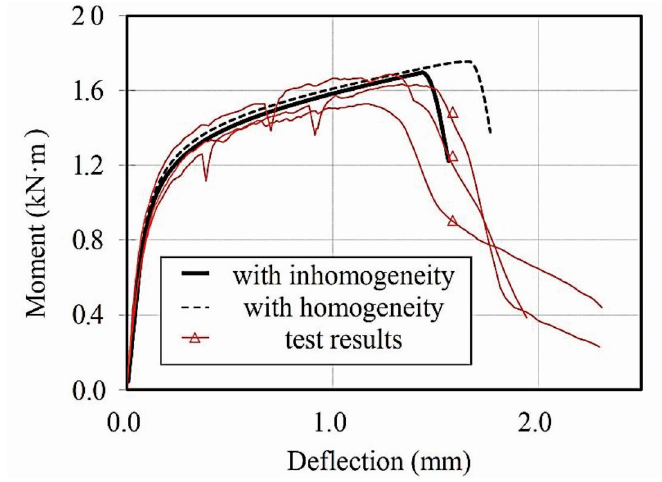
Figure 11. Moment–deflection curve of